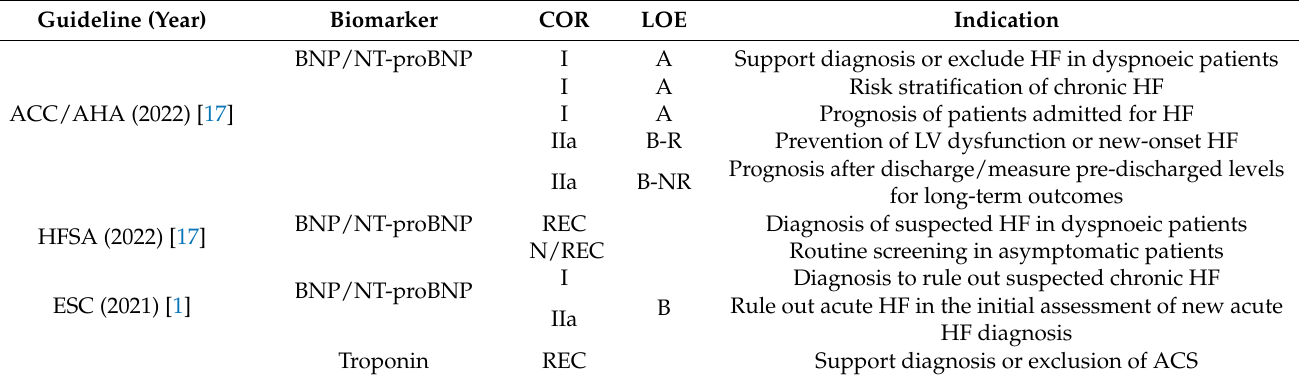
Table 1. Biomarkers recommended for heart failure (HF) by the guidelines.